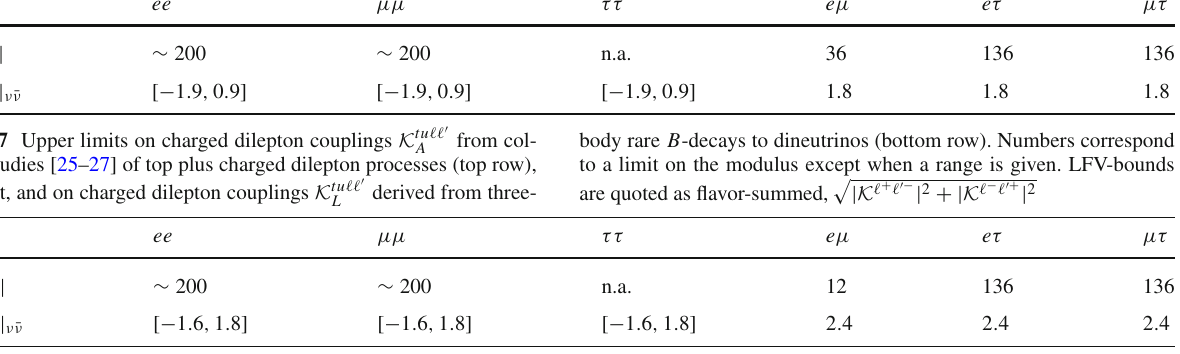
from col- body rare B -decays to dineutrinos (bottom row) except when a range is A given. Numbers correspond to a limit on the modulus. LFV-bounds are (cid:9) (cid:2) | K (cid:4) + (cid:4) (cid:2)− | 2 + | K (cid:4) − (cid:4) (cid:2)+ | 2 derived from three- quoted as flavor-summed, L